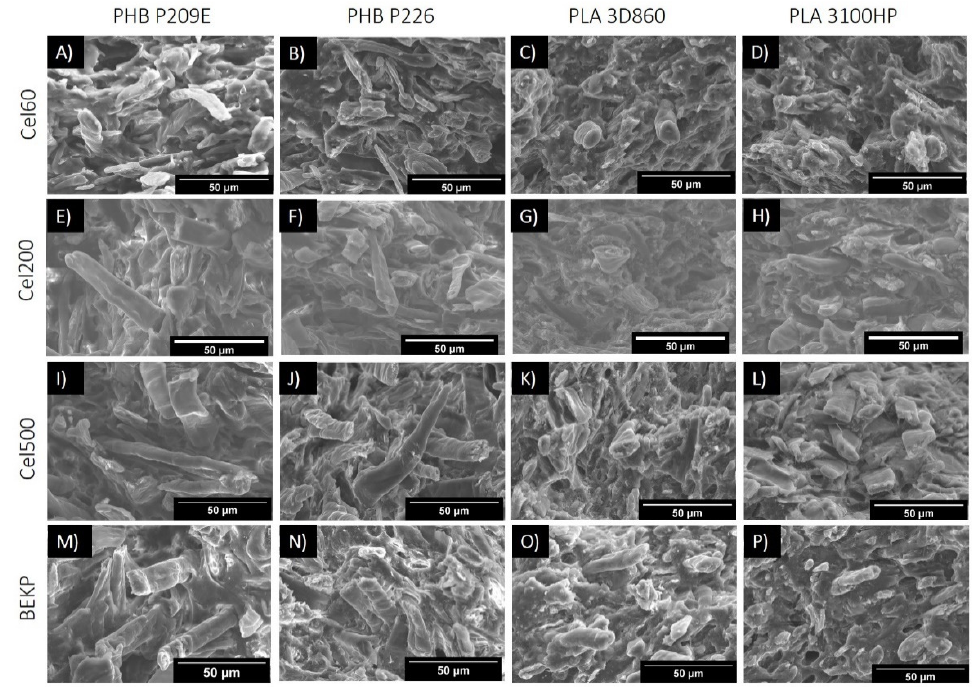
Figure 4. SEM micrographs of the fractured surfaces of composites with fibers having different aspect ratios: ( A – D ) Cel60; ( E – H ) Cel200; ( I – L ) Cel500 and ( M – P ) BEKP